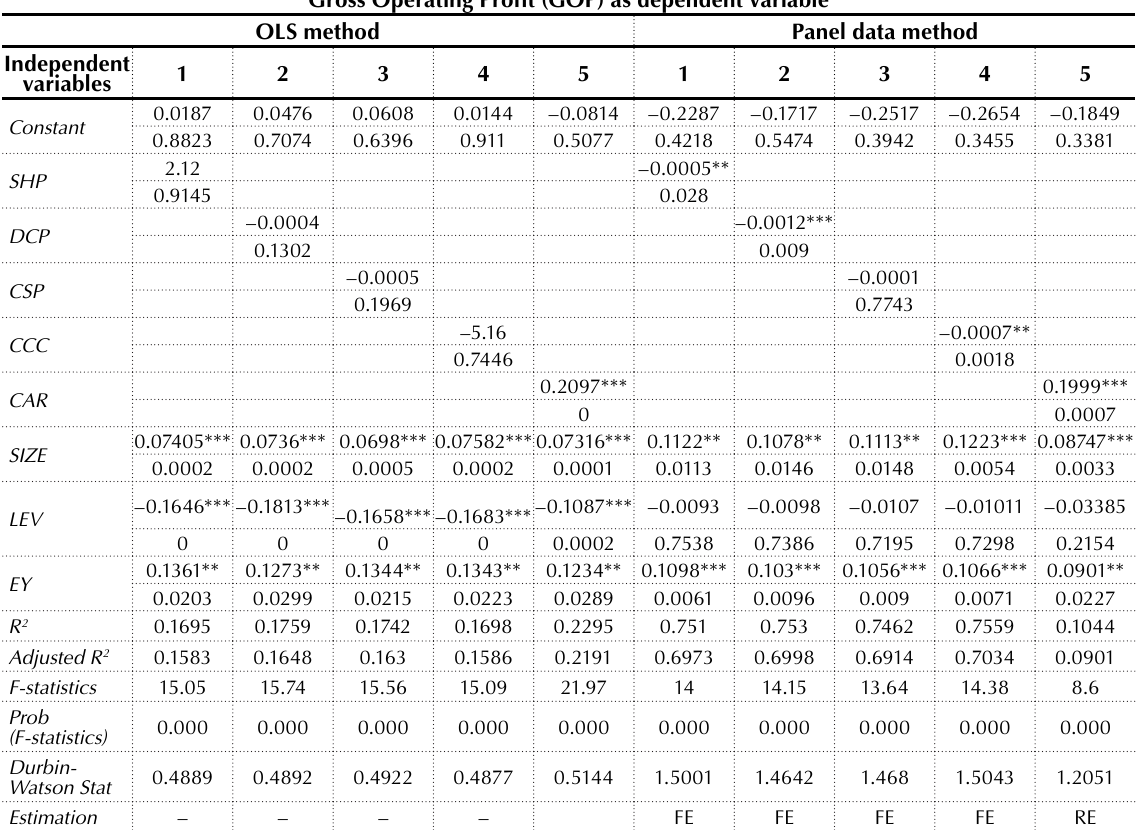
Table 5. The impact of WCM on profitability Gross Operating Profit (GOP) as dependent variable OLS method Panel data